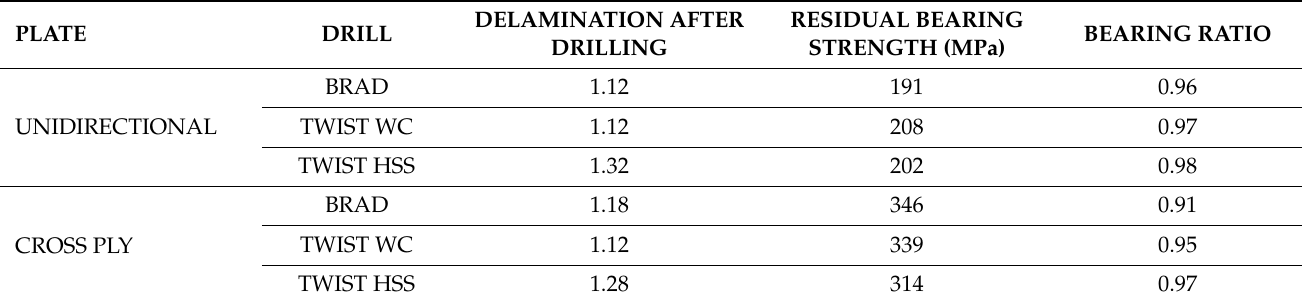
Table 6. Residual bearing strength of plates after cyclic testing.